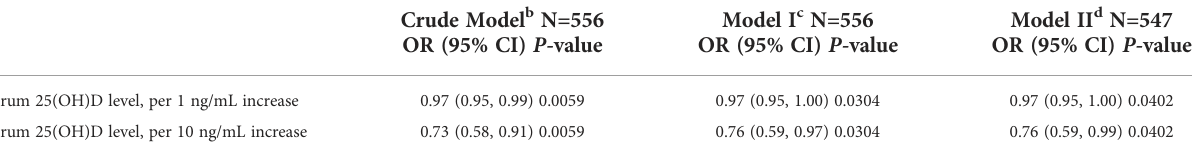
TABLE 5 Association between serum 25(OH)D levels and CRP + (CRP >0.8mg/dL) risk in various models.